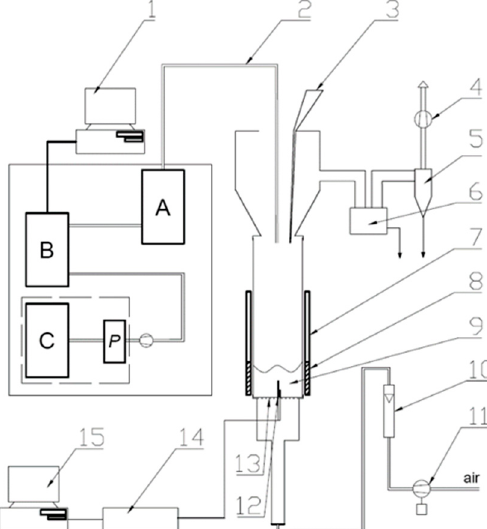
Figure 1. Scheme of fluidised bed reactor: 1—computer storing data from FTIR analyser;